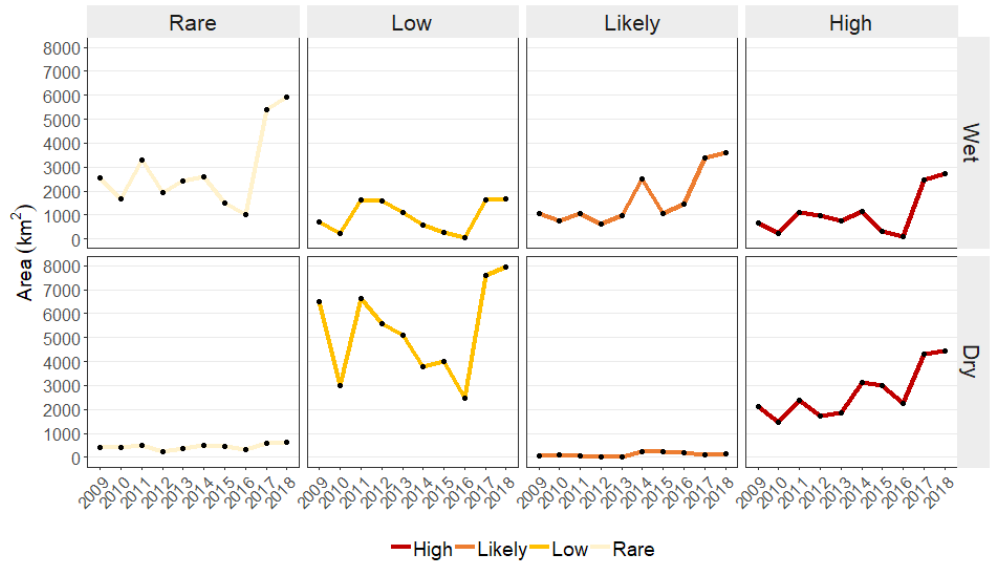
Figure 5. Total areas of human–elephant conflict under each category showed an overall increasing trend from 2009 to 2018 with larger affected areas under High category in the dry season.